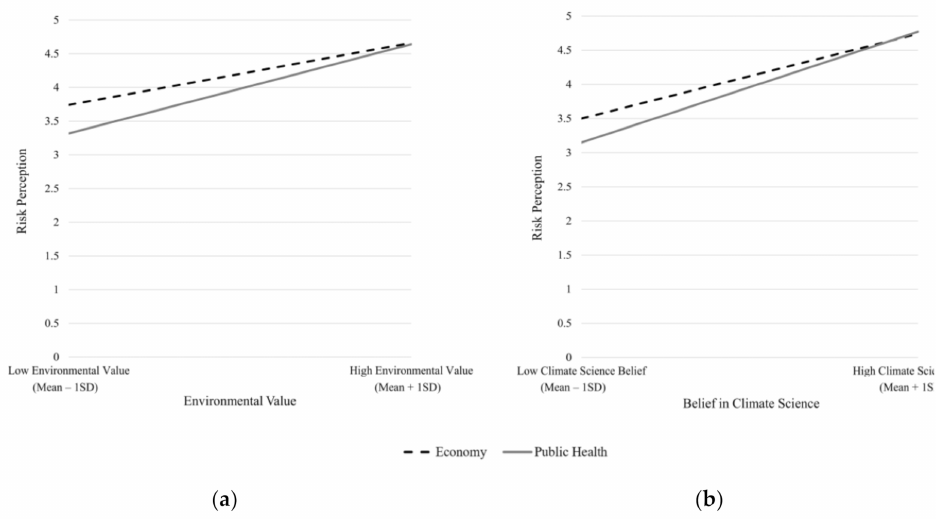
Figure 4. ( a ) Issue framing interacts with environmental value to influence risk perception; ( b ) Issue framing interacts with belief in climate science to influence risk